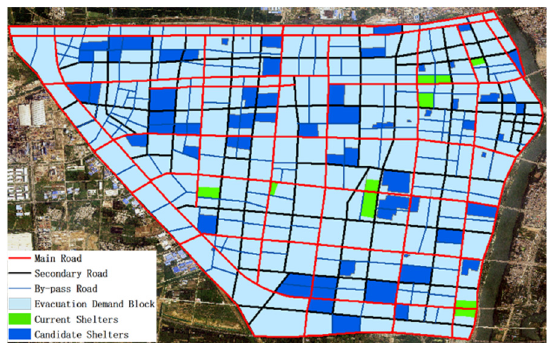
Table 2. The number of refugees at each moment and the age structure of the demand points.